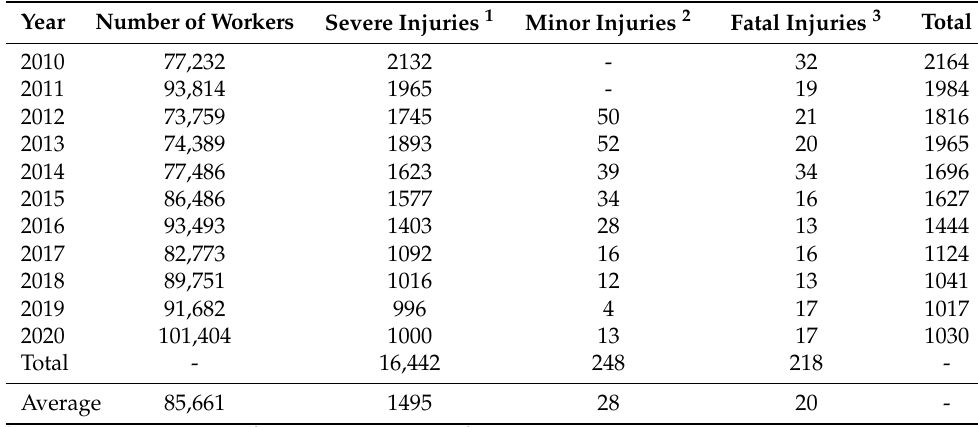
Table 1. Summary of accident data for the forestry sector between 2010 and